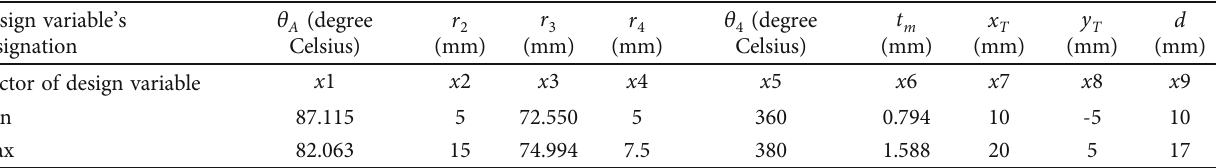
Table 3: Design parameter value bounds of thumb ’ s mechanism